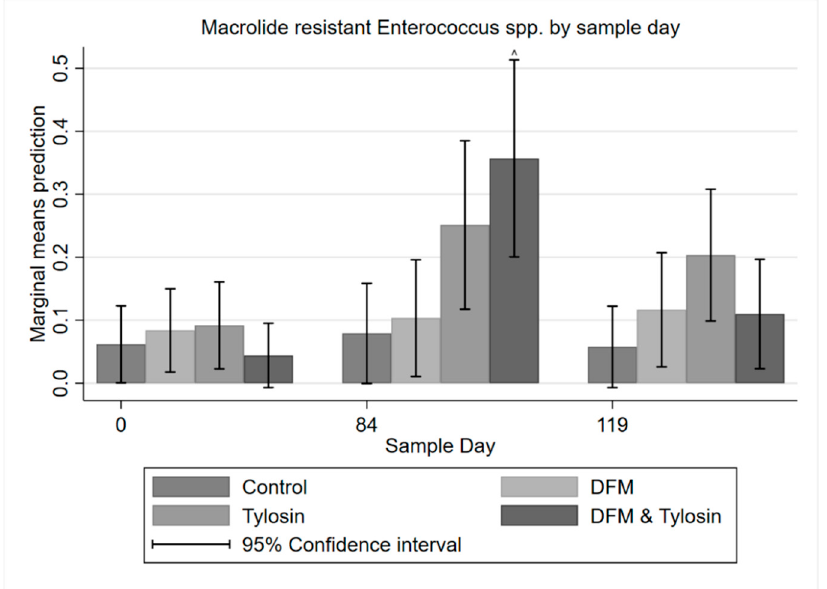
Figure 6. Marginal means with 95% confidence intervals of a 2 × 2 × 2 multi-level mixed logistic regression model, using factors of DFM, tylosin, and sample day on the binary outcome of macrolide resistant Enterococcus spp. ˆ Significantly different from respective treatment group on Day 0 and Day